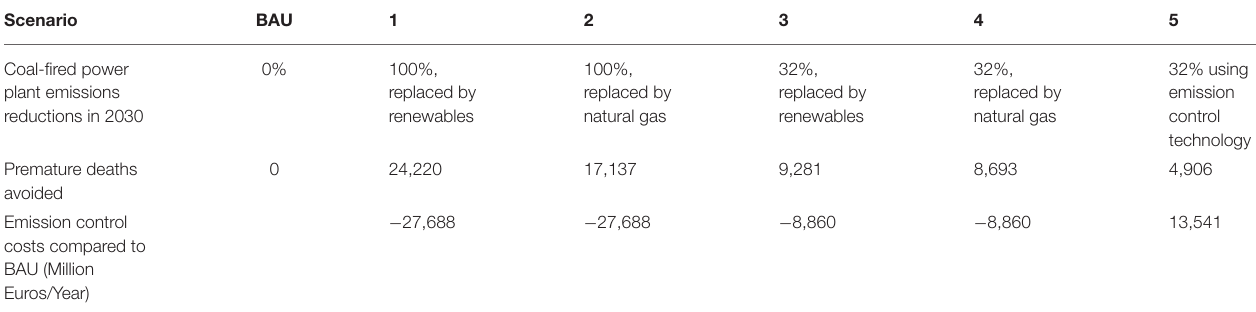
TABLE 2 | Energy scenarios’ emissions reductions, premature deaths avoided, and costs compared to Business-as-usual (BAU). Scenario BAU 1 2 Coal-fired power plant emissions reductions in 2030